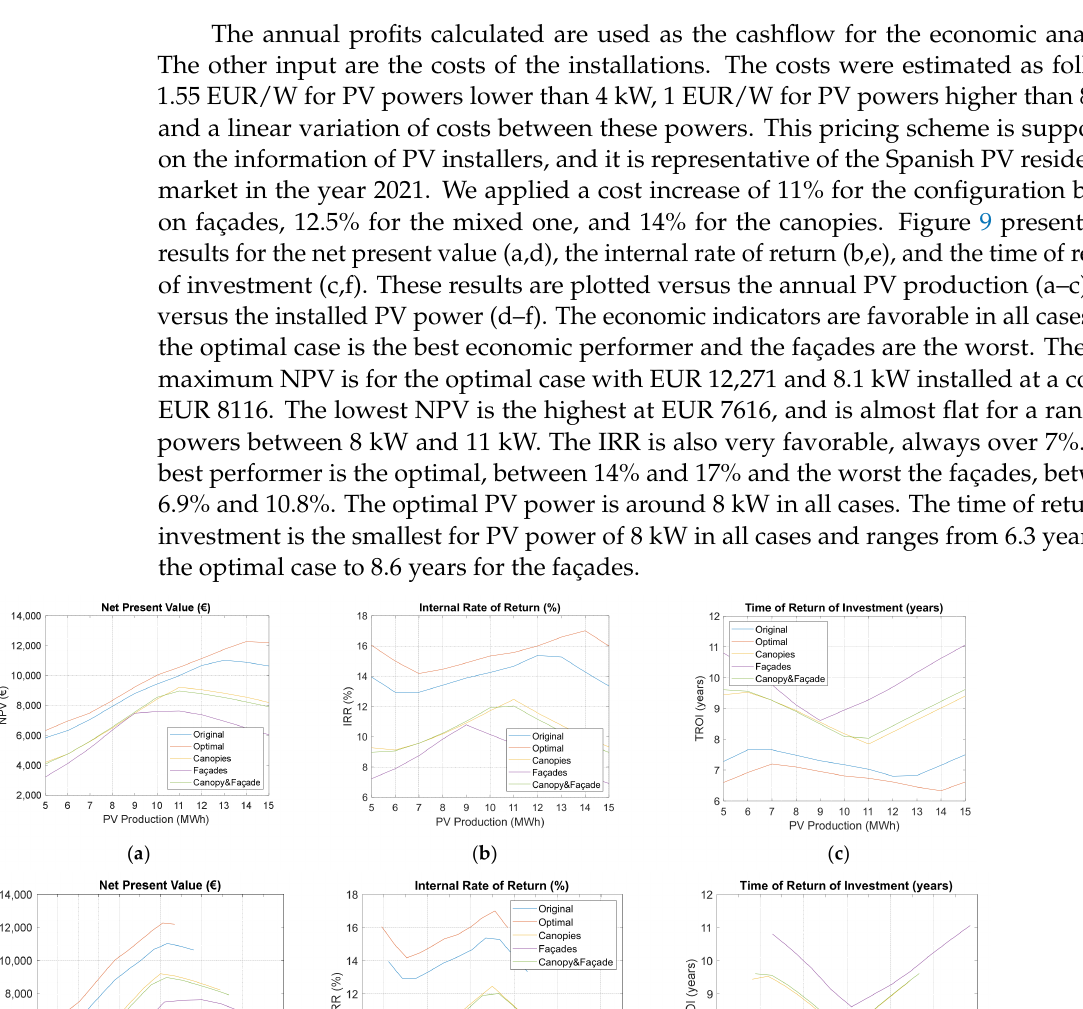
Figure 8. Economic profit for older and new electricity tariffs in Spain: ( a ) Annual profit for older tariff 2.0A; ( b ) Annual profit for the new tariff 2.0TD. Taxes of 5.11% of electricity and 21% VAT are included in the calculations.